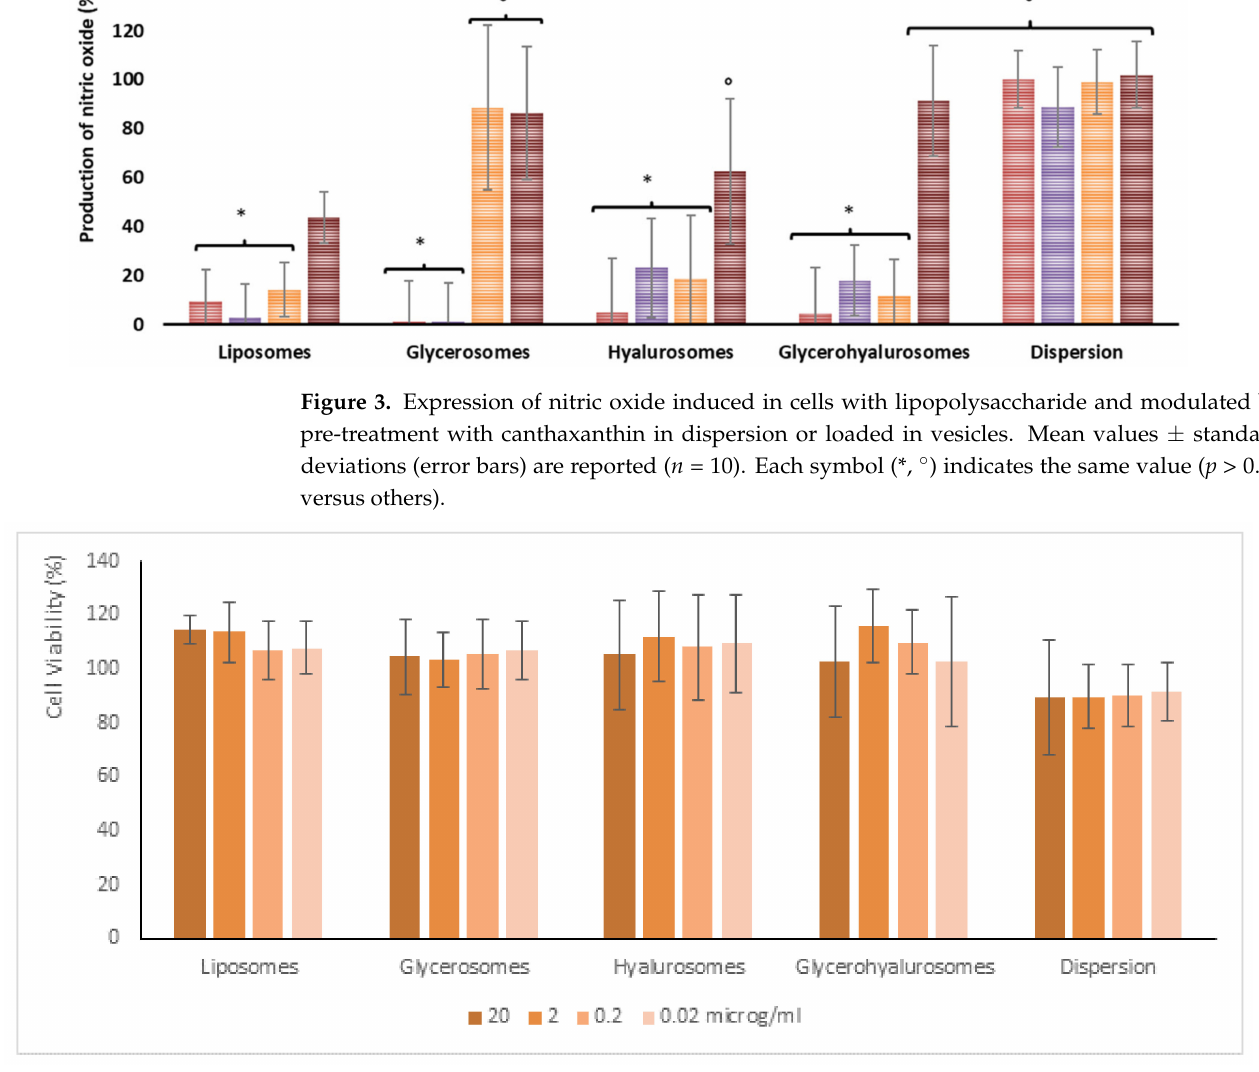
Figure 4. Cell viability of fibroblasts treated for 48 h with canthaxanthin in dispersion or loaded in vesicles diluted to reach 0.02 µ g/mL, 0.2 µ g/mL, 2 µ g/mL, and 20 µ g/mL of bioactive molecule. Data are reported as mean values ( n = 9) ± standard deviations (error bars) of cell viability expressed as the percentage of untreated cells (100% of